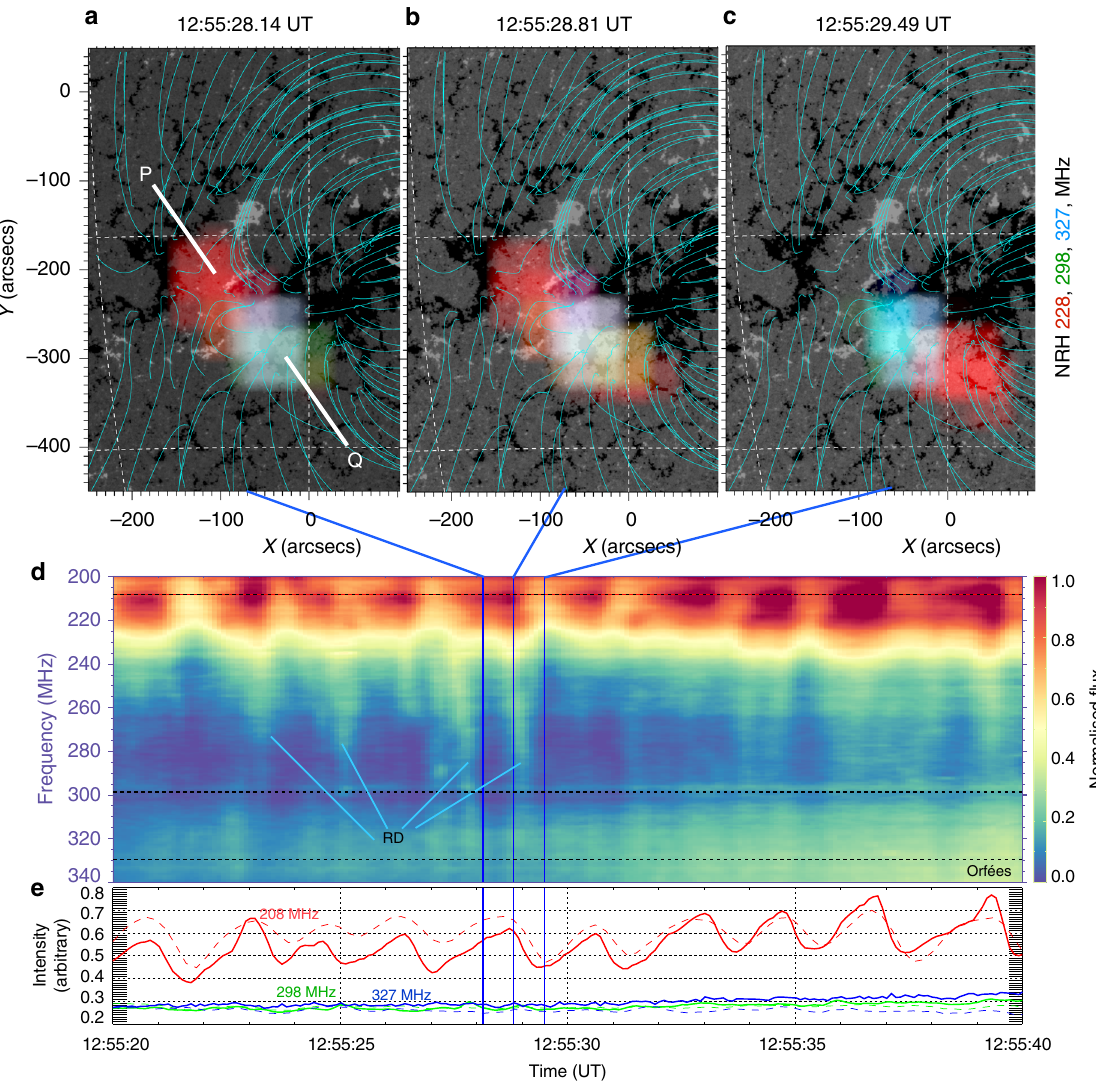
Fig. 4 Radio source behaviour of one pulsation. a – c NRH sources at 228 MHz (red), 298 MHz (green) and 327 MHz (blue) overlaid on a HMI magnetogram, with NLFFF extrapolation shown in blue. d The dynamic spectrum shows a zoom of 10 pulsations, most of which have reverse drift bursts or signatures of electron beams. e The intensity pro fi les are from Orfées (solid lines) and the closest frequencies in NRH (dashed lines), showing a sawtooth pattern at 208 MHz (Orfées) and 228 MHz (NRH). During the rise phase of the sawtooth, 228 MHz emission increases at P. Starting at the emission peak, and at the time of the reverse drifters (labelled RD) formation in the dynamic spectrum, the 228 MHz source begins to elongate towards Q. During pulse decay the 228 MHz source diminishes at P. During the process, the higher frequencies remain steady in intensity and position around Q. The process lasts for approximately 2 s and then repeats with a new pulsation, see Supplementary Movie